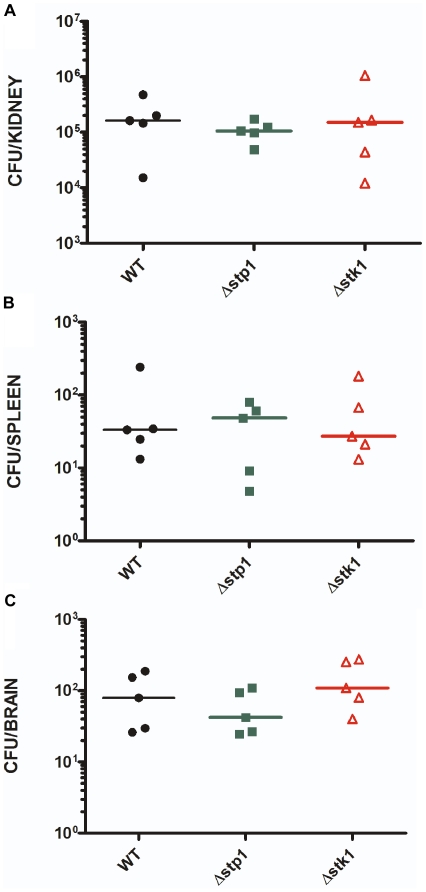
Stp1 and Stk1 do not regulate in vivo proliferation of S. aureus.Five, six week old female C57Black6 mice were intravenously injected with 1×107 CFU of WT, Δstp1 or Δstk1 strains. At approximately 5 days post-infection, kidneys, spleen, and brains were harvested from infected mice and bacterial CFU enumerated. Note that the CFU of WT, Δstp1 or Δstk1 S. aureus were not significantly different in the kidneys (A), spleens (B) or brains (C) of infected mice.